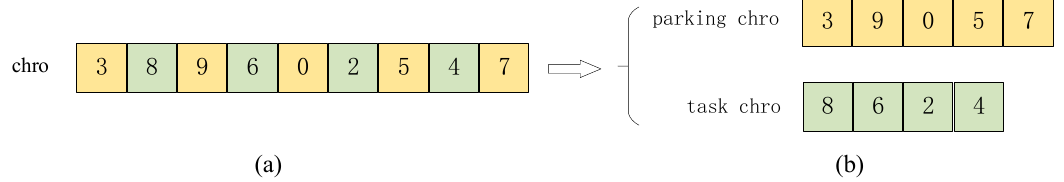
Figure 7. An illustration of chromosome layering before the mutation operation: ( a ) chromosome before layering; ( b ) chromosome after layering.